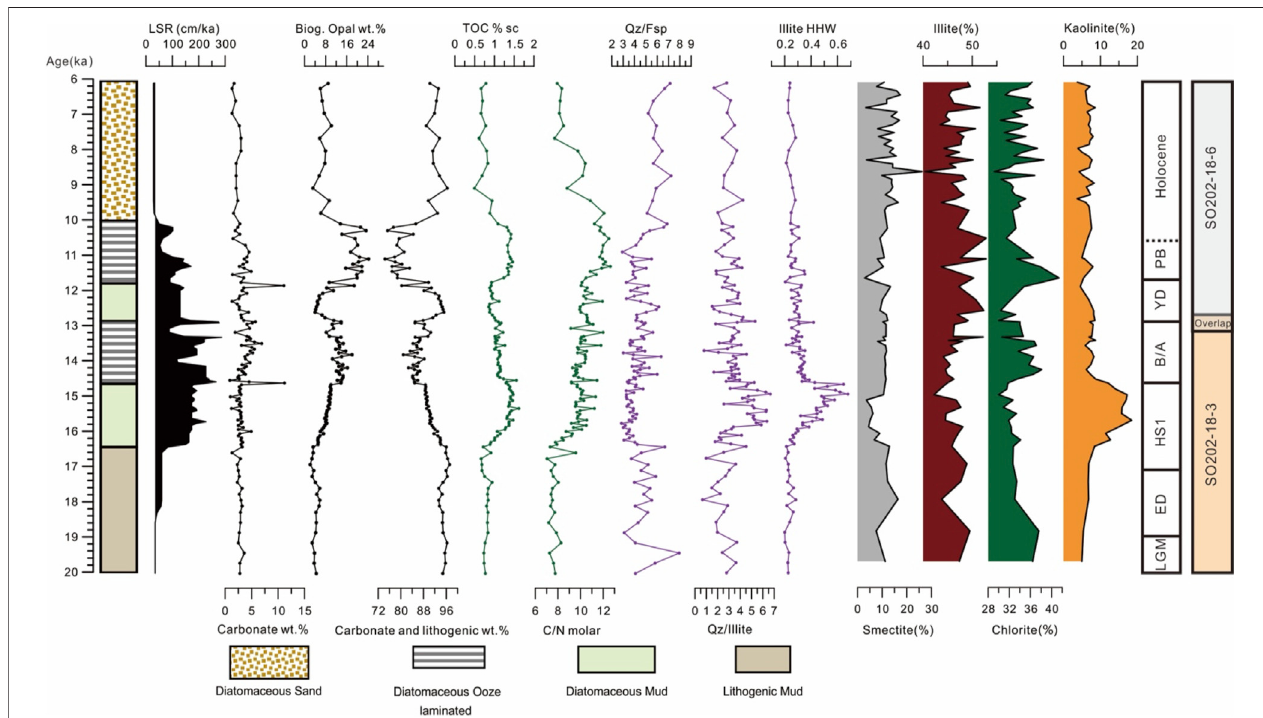
FIGURE2| CompositesectionofsedimentcoresSO202-18-3/-6,showingdowncoreandtemporalvariationsinlithology,linearsedimentationrates(LSR),weight percentages(wt%)ofthesedimentcomponentsofcarbonate,biogenicopal,totalorganiccarbon(TOC),themolarratiooftotalorganiccarbonversustotalnitrogen(C/N ratio). Mineralogical X-ray diffraction data comprise quartz/feldspar ratios (Qz/Fsp), quartz/illite ratio (Qz/Illite) of bulk sediment, illite crystallinity (Illite HHW, and mineralogical composition (%) of the clay fraction: Smectite, Illite, Chlorite, Kaolinite).